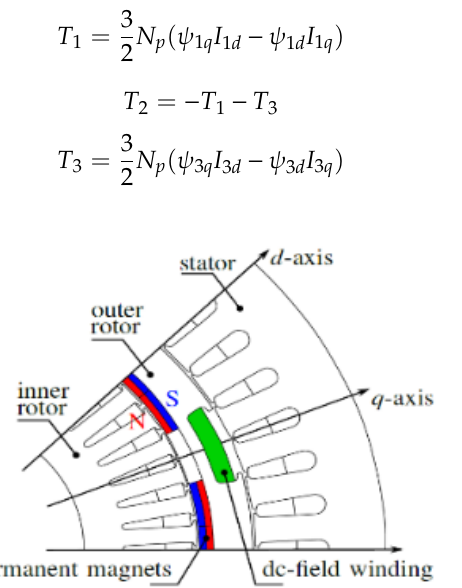
Figure 3. Cross-sectional view of the permanent magnet (PM) EVT.